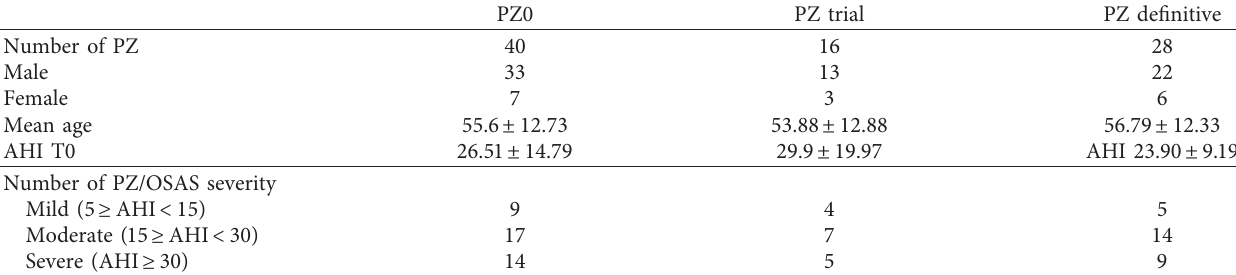
Table 1: Participants’ characteristics and the devices used in each